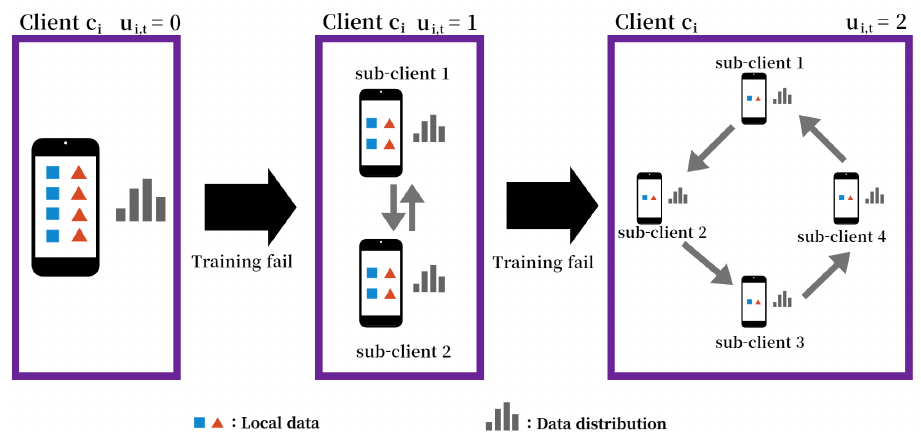
Figure 4. Example of